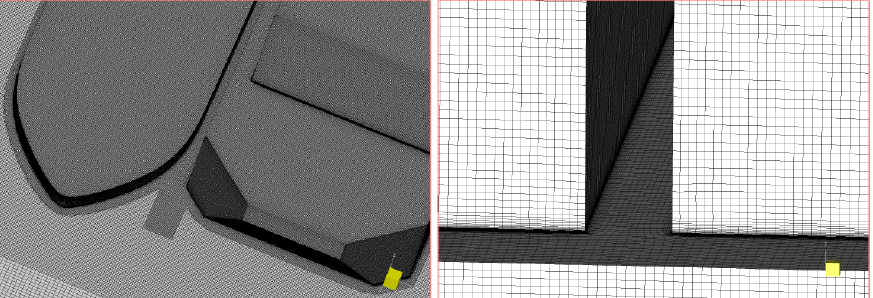
Figure 15. Finest grid system for the side-by-side case; ( left ) bow section including additional box refinement between the two vessels and ( right ) superstructure. Table 3. Meshes used for the side-by-side simulations. Gaps